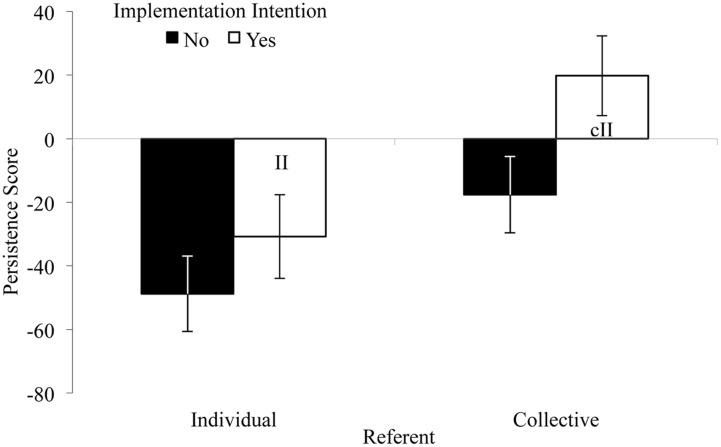
Mean persistence scores (experimental [s] minus baseline [s]) by Implementation Intention and Referent (Experiment 1). Error bars represent standard errors. II: Individual implementation intention; cII: collective implementation intention.